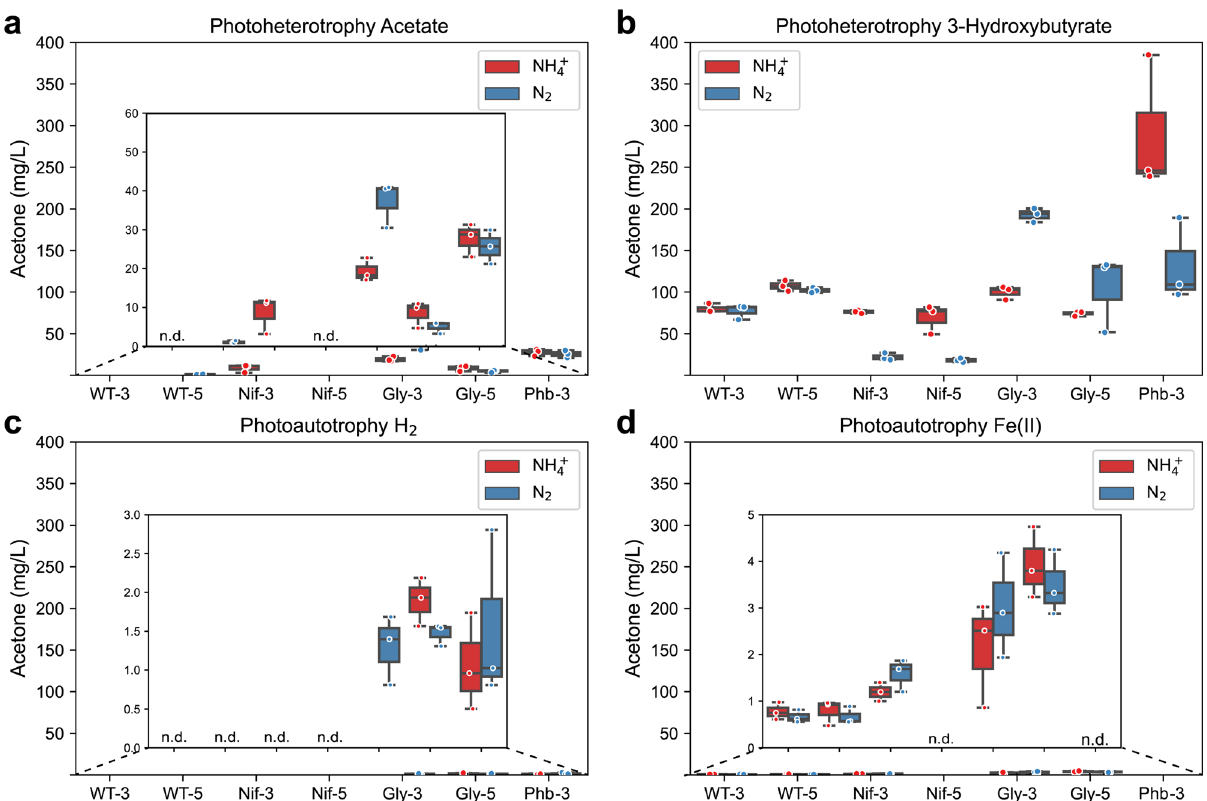
Fig. 4 High n -butanol production correlates to low acetone production amongst TIE-1 mutants. The concentration of acetone in mg/L when TIE-1 was cultured with ammonium (NH 4 + , red) or dinitrogen gas (N 2 , blue) and a acetate (photoheterotrophy) b 3-hydroxybutyrate (photoheterotrophy) c hydrogen (H 2 ) (photoautotrophy) and d ferrous iron [Fe(II)] (photoautotrophy). CO 2 was present in all conditions. Data are from n = 3 of